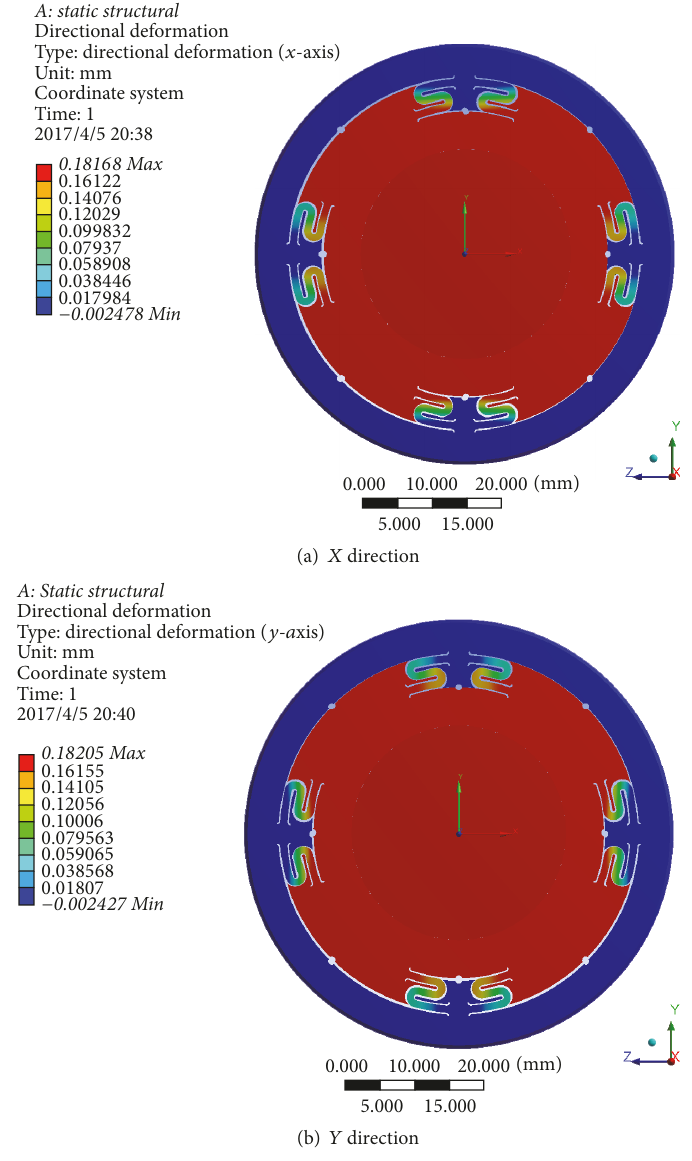
Figure 4: Displacement cloud of ISFD under a loading of 6000N.